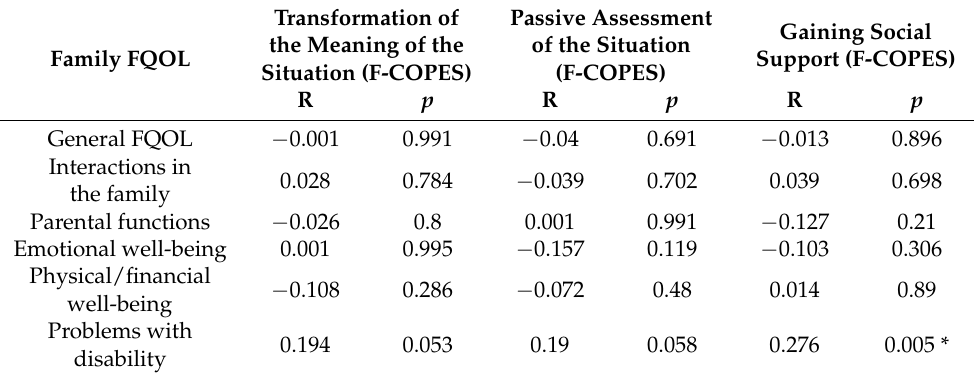
Table 6. Transformation of the meaning of the situation, passive assessment of the situation and gaining social support and the level of FQOL in the assessment of children and adolescents from the control group. Passive Assessment Transformation of Gaining Social of the Situation the Meaning of the Family FQOL Support (F-COPES) (F-COPES) Situation (F-COPES) R p R p R p General FQOL − 0.001 0.991 the family Emotional well-being 0.001 − 0.108